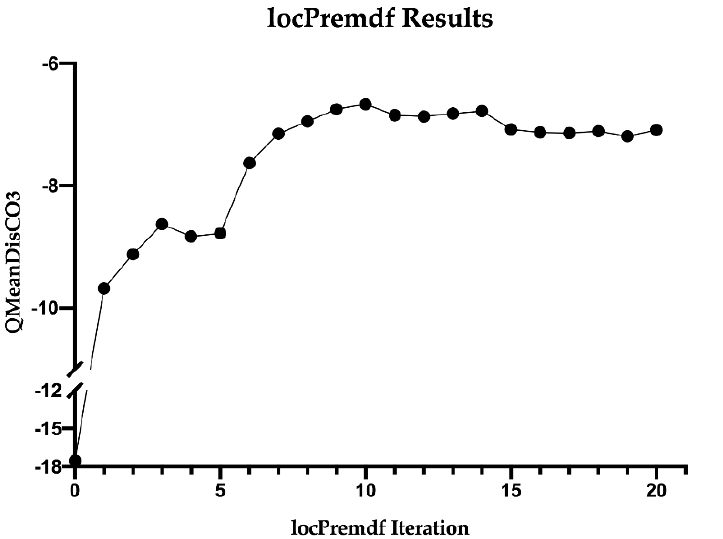
Figure 3. locPremdf results. Iteration 0 corresponds to initial L. amazonensis ODC I-Tasser modeling. QMeanDisCo3 results are scored by QMEAN4. A higher value indicates better folding.